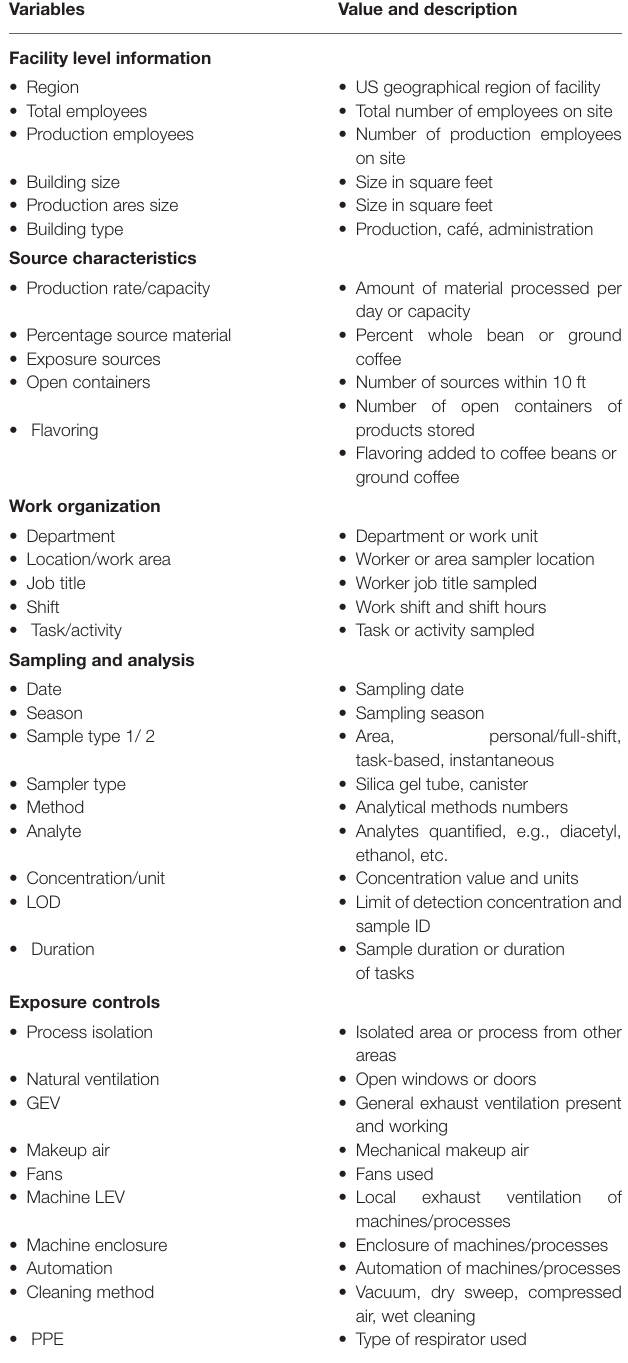
TABLE 1 | Data elements collected during the 17 HHEs to describe exposures. Variables Value and description Facility level